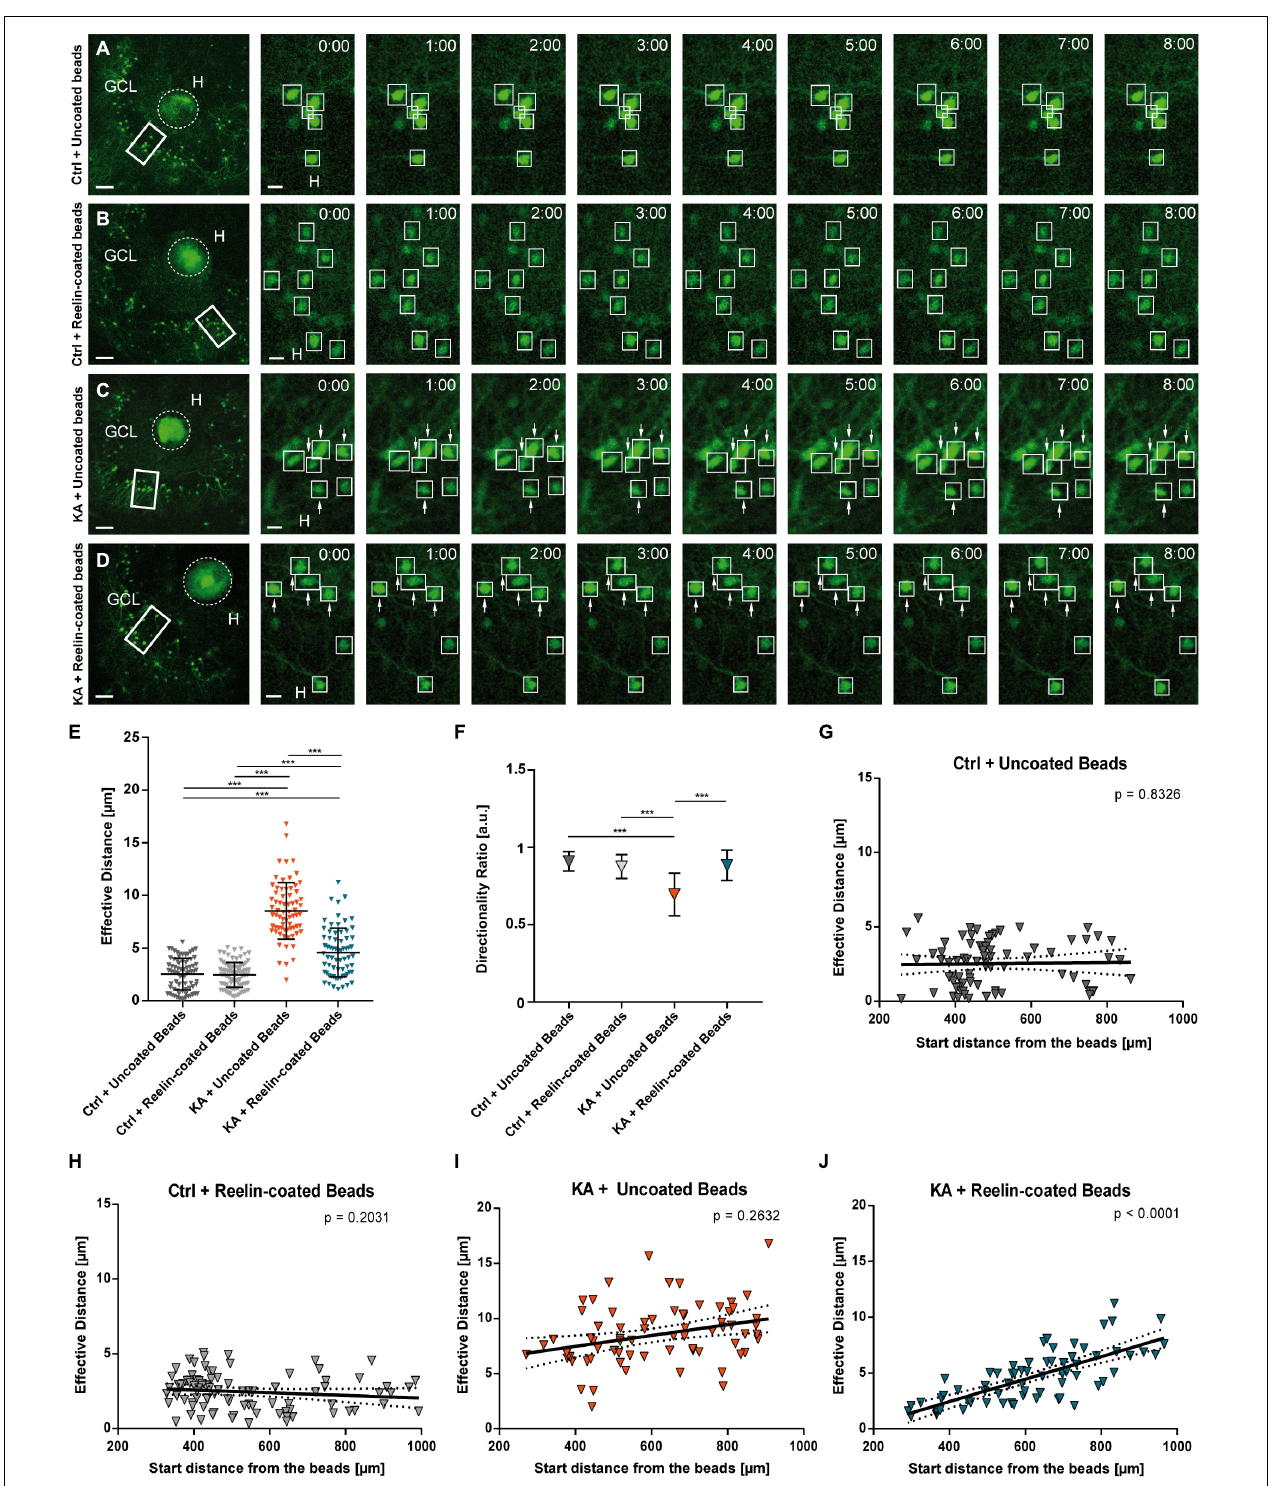
FIGURE 4 | Placement of Reelin-coated beads into the hilus stops KA-induced migration. Live cell imaging of individual eGFP-positive GCs was performed over a period of 8 h, and migration distances of automatically selected neurons were assessed. Cell motility was determined by calculating both the total length of the traveled path over 8 h and the effective migration distance as the length of the resulting vector between start ( t = 0 h) and end point ( t = 8 h). The border between the beads and GCL was marked and the distance was calculated between the start and end point of the cells to this border. (A–D) Representative confocal